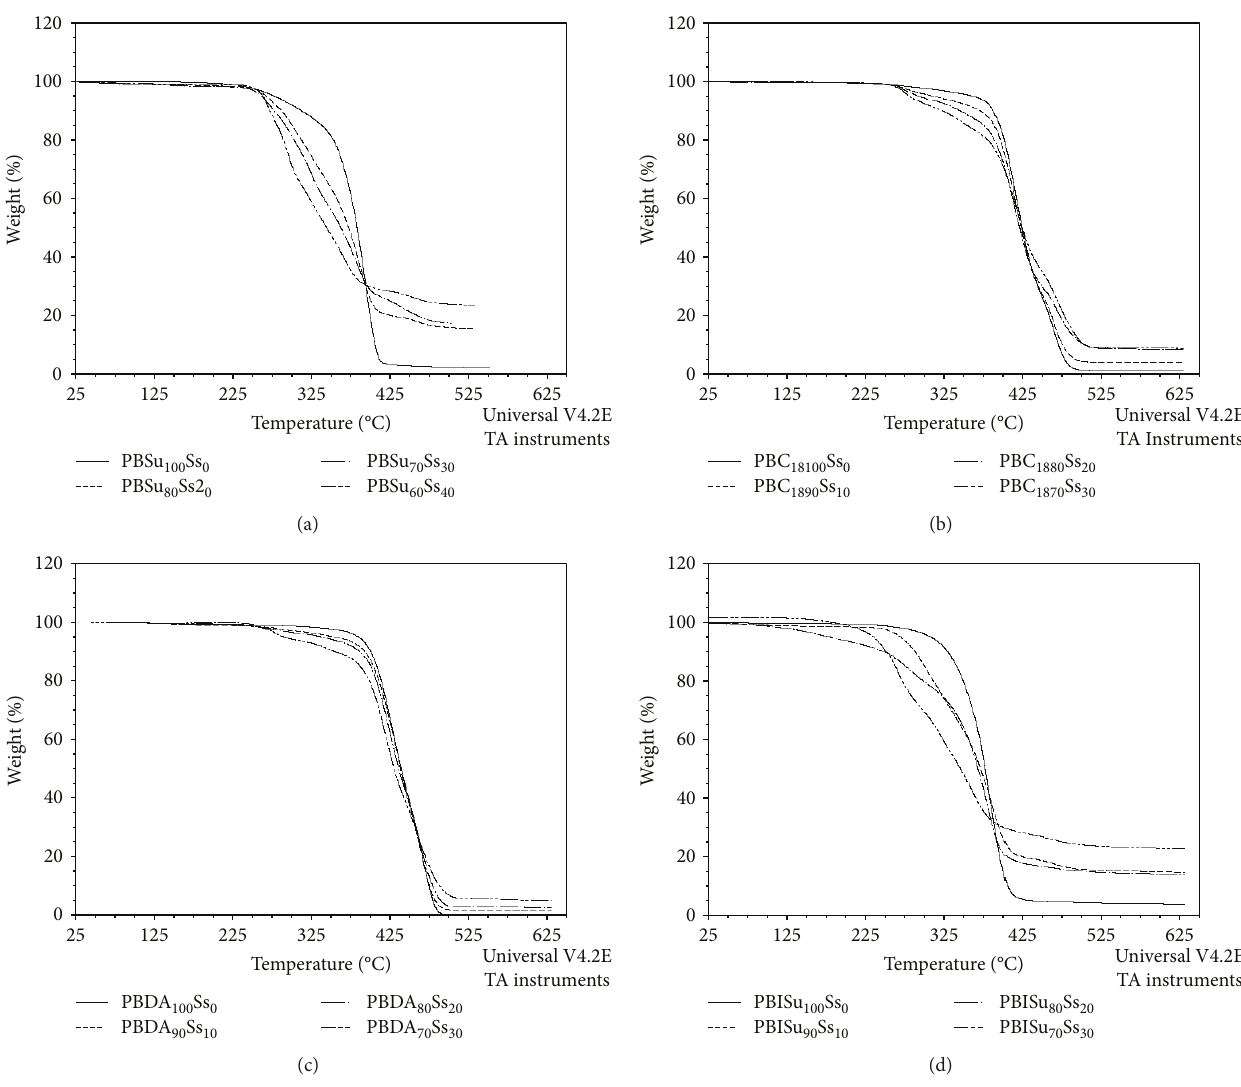
Figure 16: TGA curves of biobased oligoesters: (a) TGA curves of PBSu TGA curves of PBISu